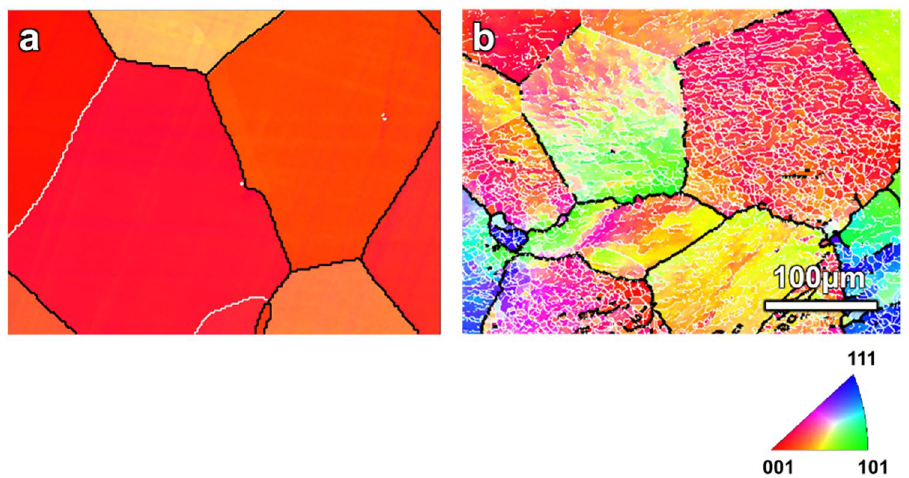
Figure 2. The Inverse pole figure (IPF) map obtained by EBSD showing ( a ) the fully-annealed coarse grains of 5N Al before t -HPS and ( b ) the sub-grain boundaries (white nets) formed in these coarse grains when the sample is subjected to a hydrostatic pressure of ~ 3 GPa. The scale bar is the same in ( a,b